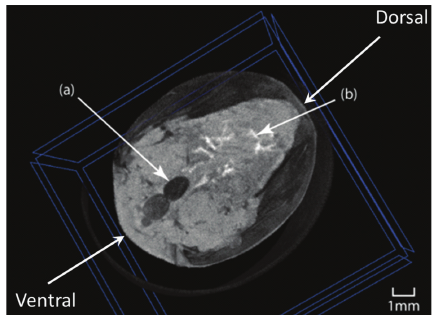
Figure 7: A 2D micro-CT image showing a transverse section through a C. septempunctata abdomen showing (a) nondense “black” radio-lucent air-sacs and (b) dense “white” radio-opaque malpighian tubules. Blue lines indicate the selectable cutting planes.